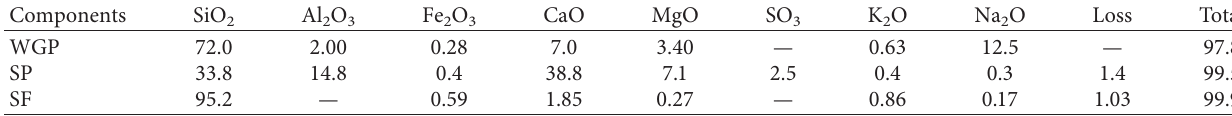
Table 1: The main chemical composition of WGP, SP, and SF (%).